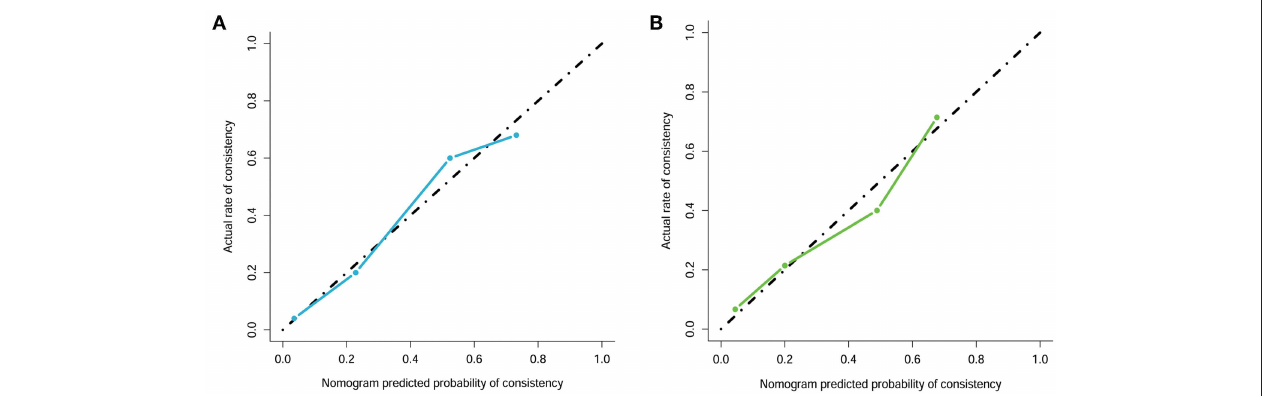
FIGURE 6 | Calibration curve analysis for the radiomics model. (A) Primary cohort. (B) Validation cohort. Calibration curves depict the calibration of each model in terms of the agreement between the predicted and actual probability of the firm tumor rate. The Y axis represents the actual rate. The X axis represents the predicted probability. The diagonal black line represents perfect prediction by an ideal model. The blue and green line represents the performance of the radiomics model, of which a closer fit to the diagonal black line represents a better prediction.